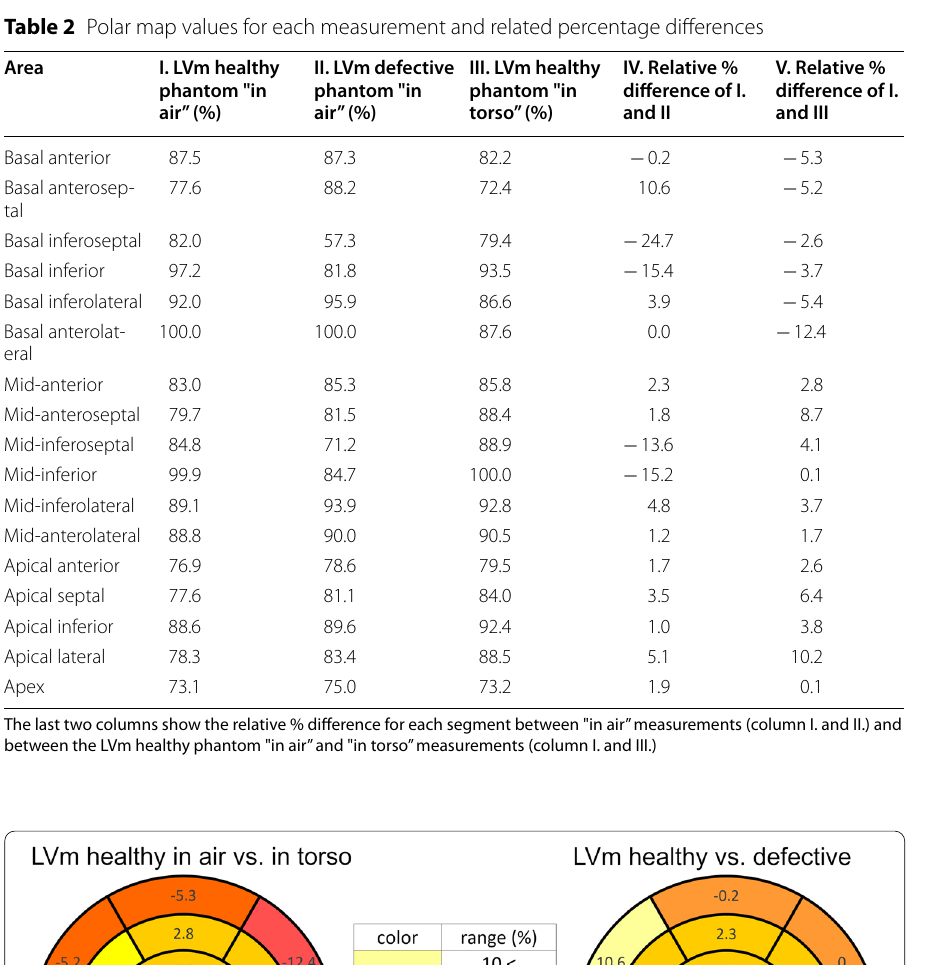
Table 2 Polar map values for each measurement and related percentage differences